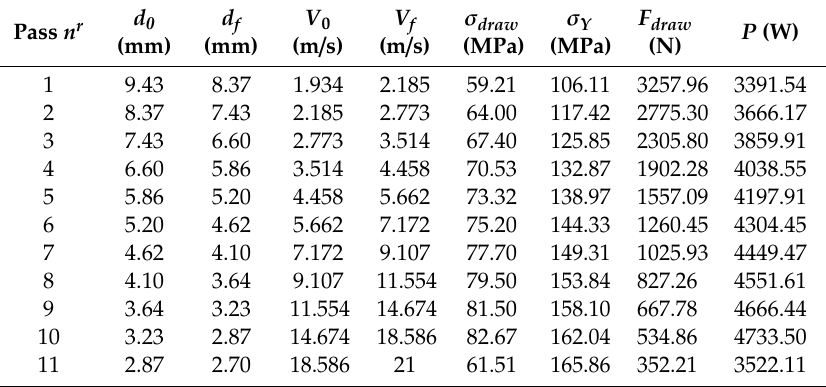
Table 7. Optimized multi-stage wiredrawing sequence by PullWorks software application (Δ = 5.20).